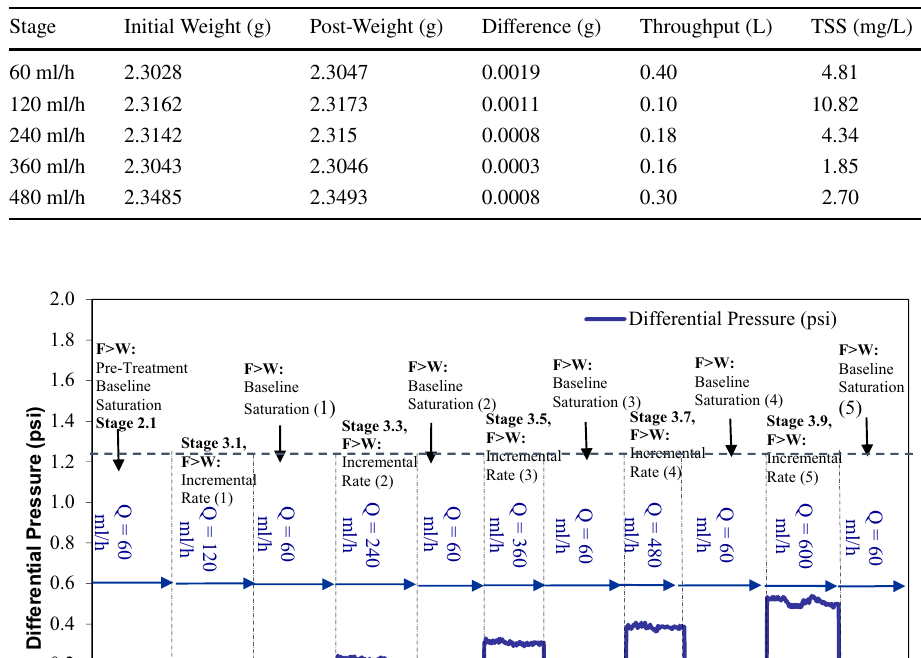
Fig. 9 Differential pressure versus time profile recorded during brine saturation at incre- mental rates and intermediate baseline saturations.